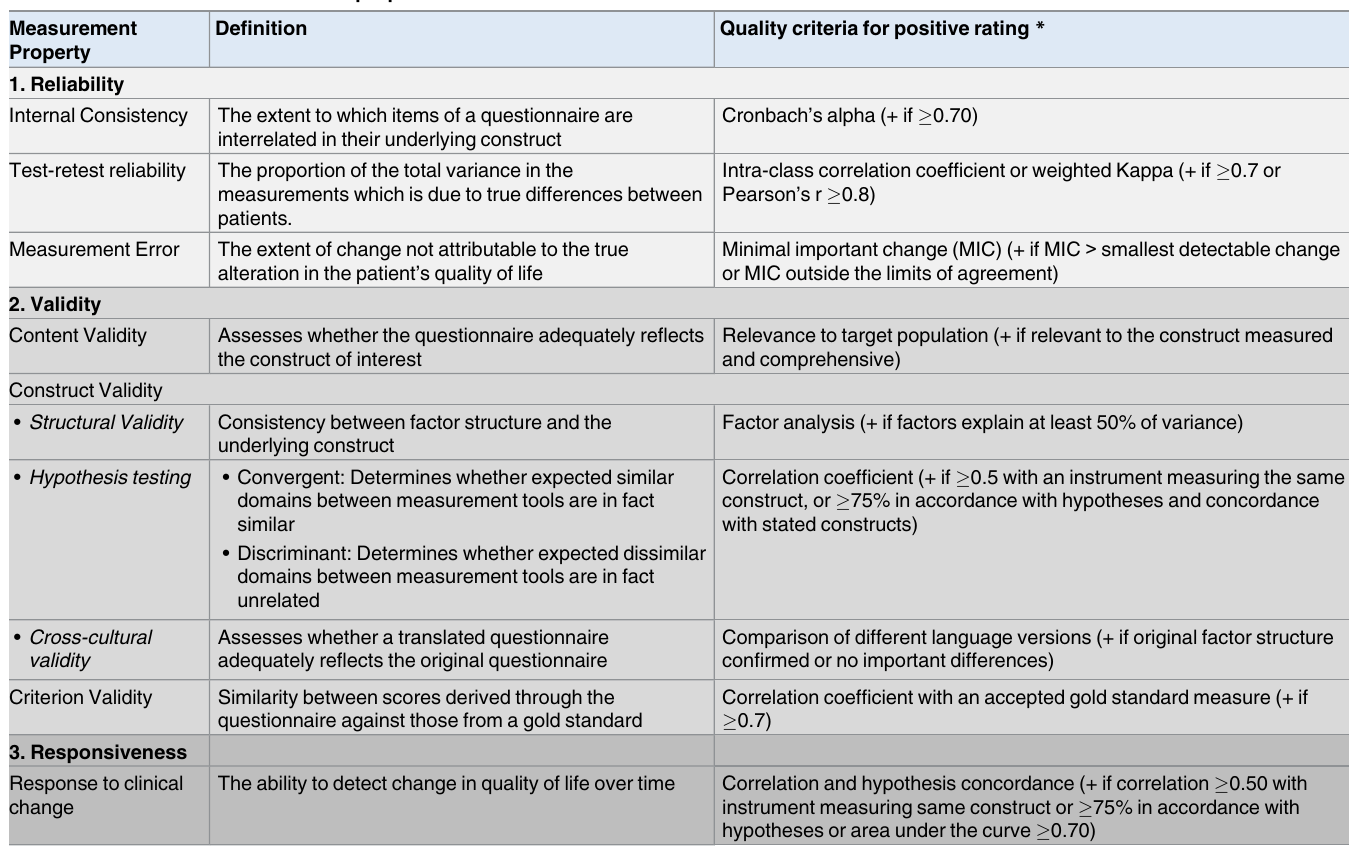
Table 1. Definitions of measurement